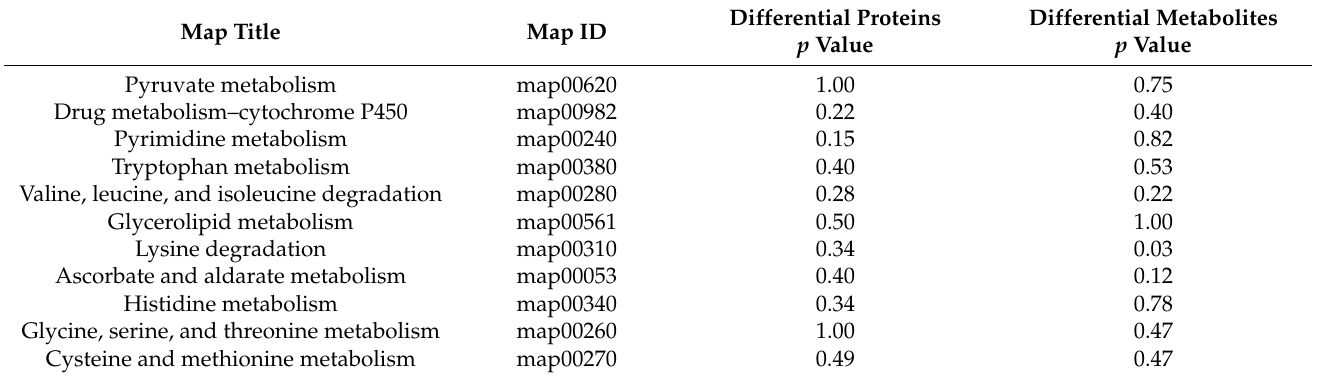
Table 3. Pathway enrichment statistics of differential proteins and differential metabolites in female silkworms.